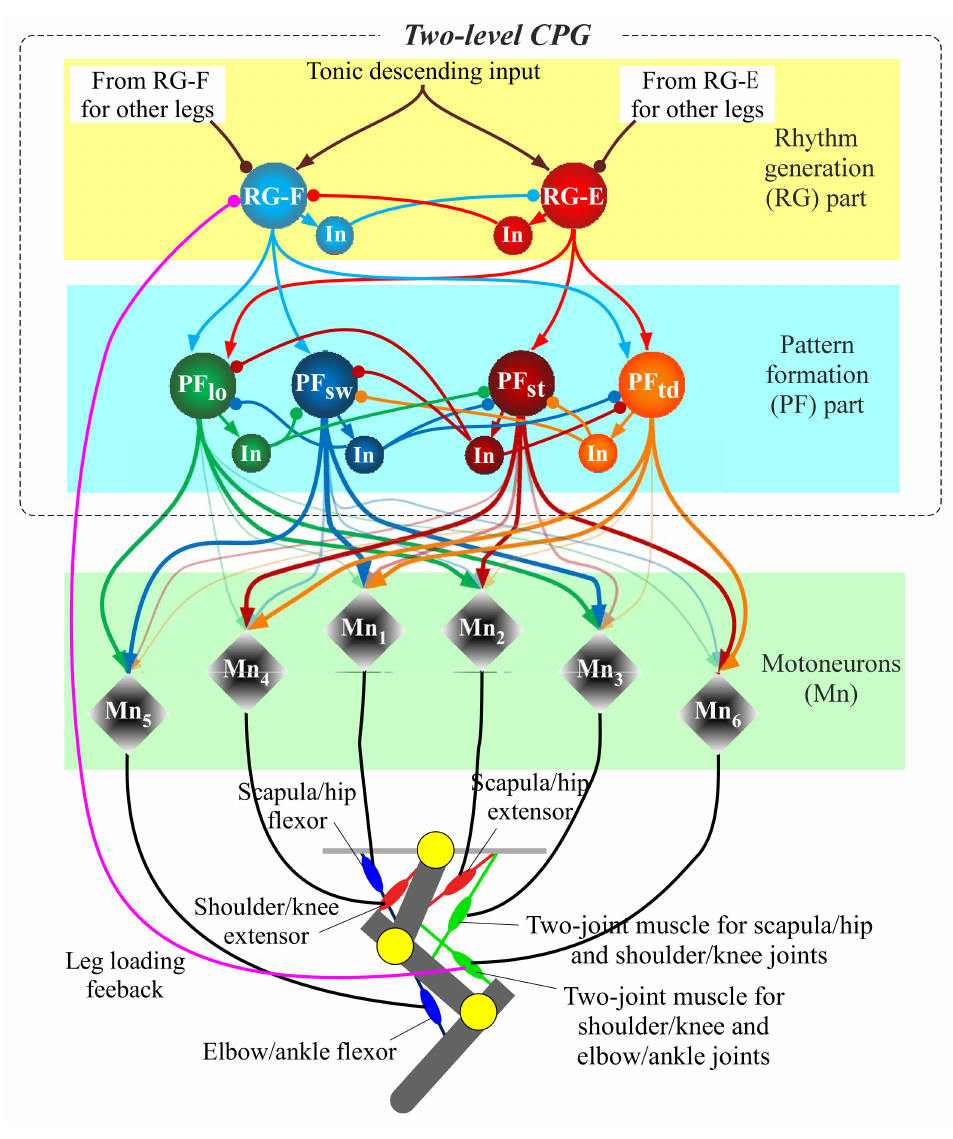
Figure 5. Diagram of the two-level central pattern generator (CPG) for each